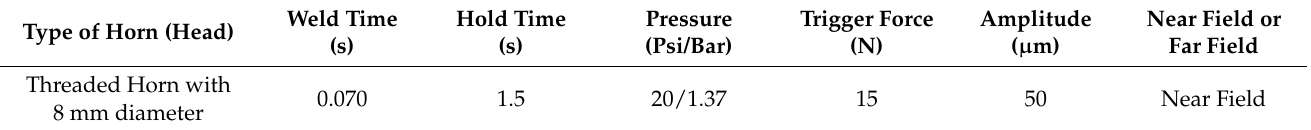
Table 1. Ultrasonic welding parameter.